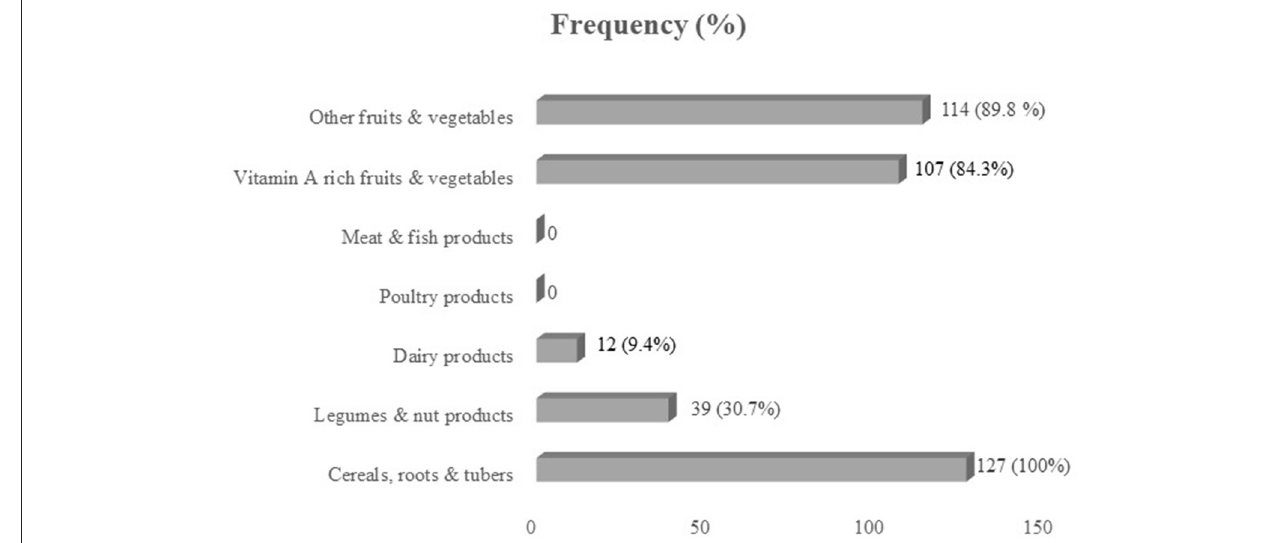
FIGURE 1 | Consumption (%) of seven food groups by school-age children in Halaba zone, SNNPR Ethiopia.